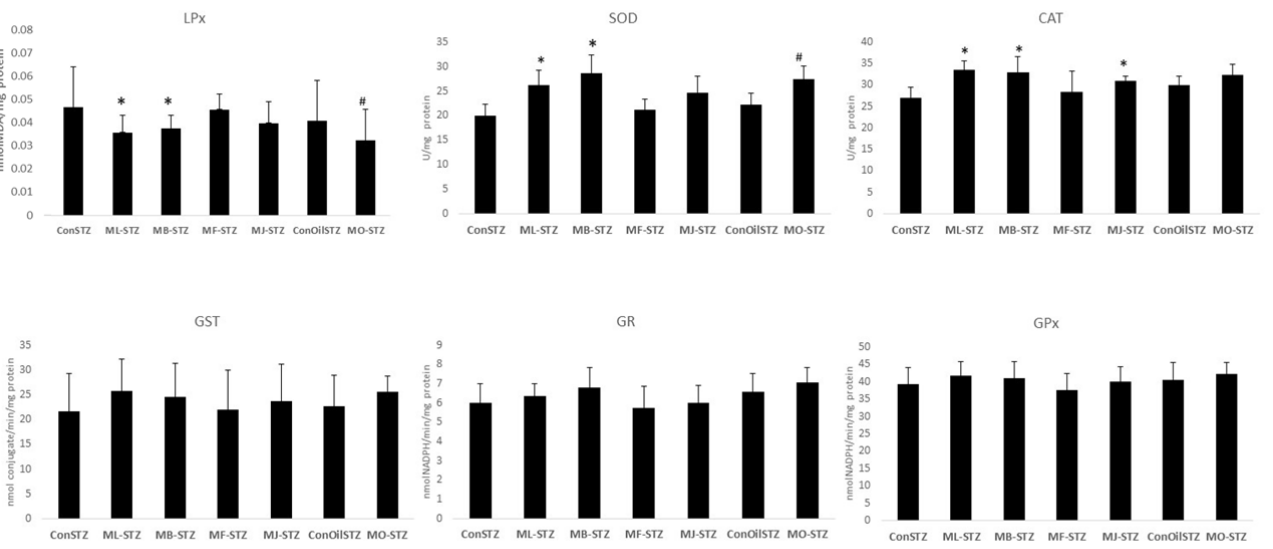
Figure 7. Effect of mulberry extracts on the levels of markers of oxidative stress and antioxidant enzymes activity in liver tissue homogenates in mice with streptozotocin-induced oxidative stress (ConSTZ — saline 10 mL/kg; ConSTZOil — olive oil 10 mL/kg; ML-STZ — black mulberry leaf ethanol extract; MB-STZ — black mulberry bark ethanol extract; MF-STZ — black mulberry fruit ethanol extract; MJ-STZ — black mulberry juice; MO-STZ — black mulberry seed oil) (LPx — lipid peroxidation; SOD — superoxid dismutase; CAT — catalase, GST — glutathione S-transferase; GR — glutathione reductase; GPx — glutathione peroxidase). * significantly different compared to ConSTZ group; # significantly different compared to ConOilSTZ group (vehicle control).